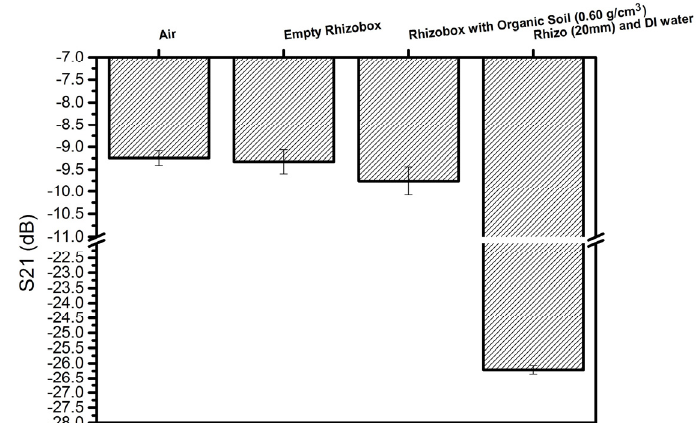
Figure 6. The peak values of scattering parameter, S 21 , measured for the following samples: lab air (Air), empty rhizobox, the rhizobox filled with one of the porous media (substrate Nullerde, an organic soil with density ρ ss = 0.60 g / cm 3 ) and DI water. The frequency used in this experiment was close to 4.8 GHz.